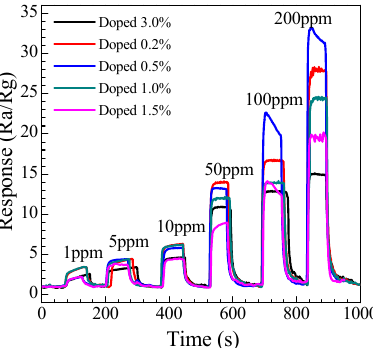
Figure 9. Typical dynamic response and recovery characteristic curves of the Eu-doped SnO 2 nanorods array sensors to methanal ranging from 1 to 200 ppm at 278 °C.